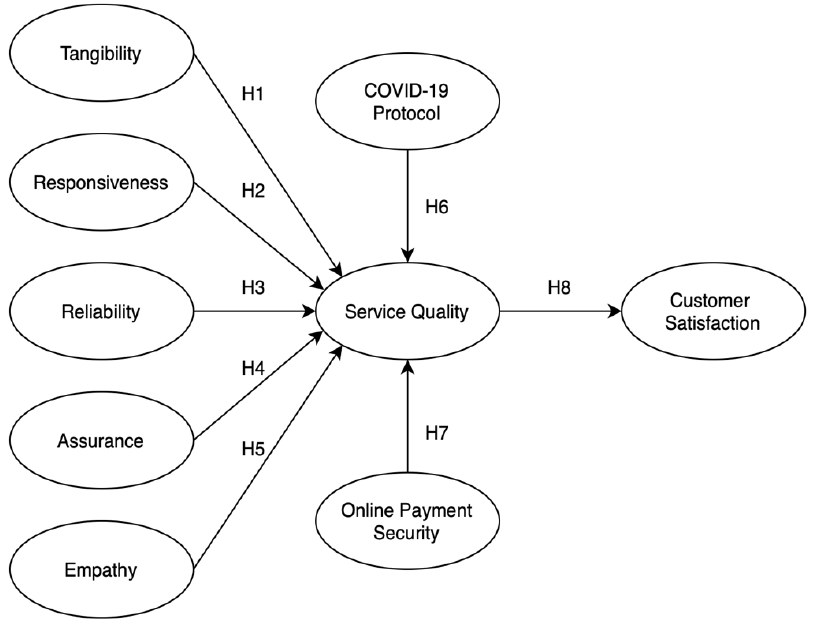
Figure 2. The conceptual framework of the study.